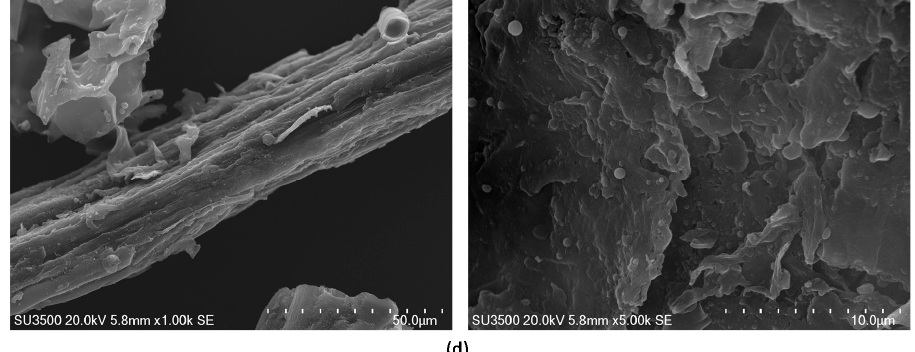
Figure 4. SEM images of carbon materials produced at 1000 °C and under the pressure of ( a ) 1 MPa, ( b ) 2 MPa, ( c ) 3 MP, and ( d ) 4 MPa.